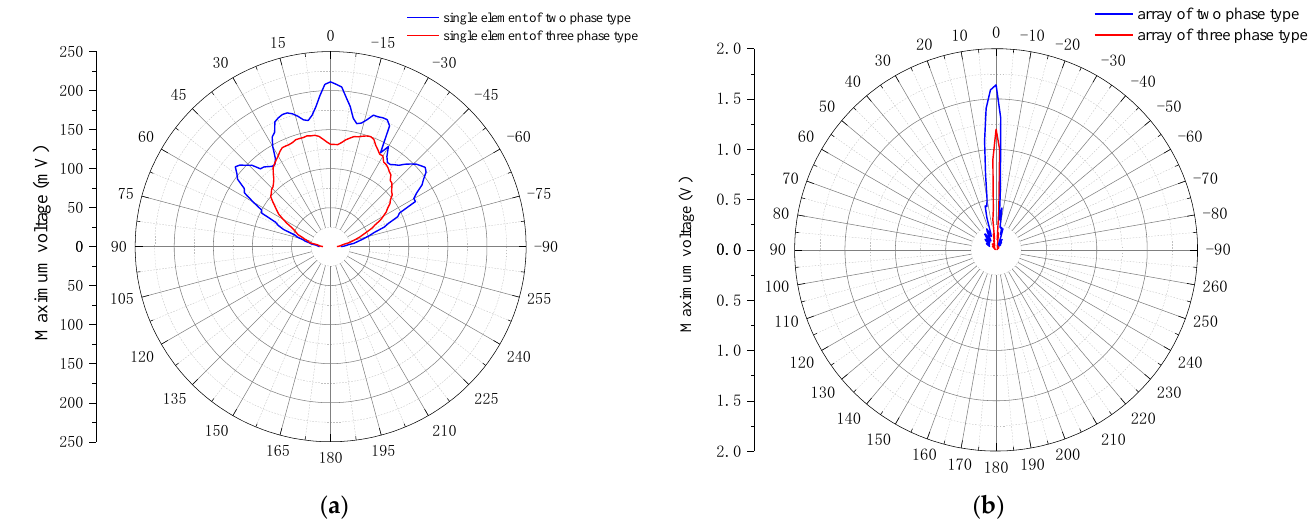
Figure 17. Horizontal beam directivity test curves of two transducers. ( a ) Horizontal directivity curves of single element of two types of transducers; ( b ) Horizontal directivity curves of two transducer array elements.